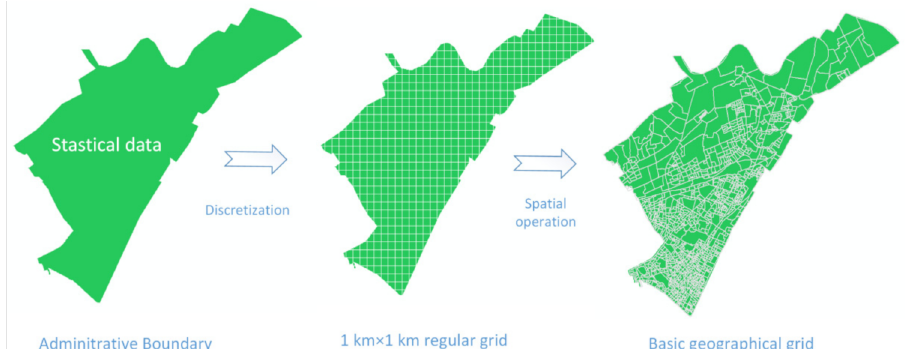
Figure 4. Then, POI data were converted into spatial data in the CGCS2000 coordinate system. The greening rate reflects ratio of green land area to total land area for each community. The text description of community greening rate is crawled from the community web page, and further the community name, community address, and greening rate were extracted. The result data of the greening rate to each community was then produced through cleaning and structural